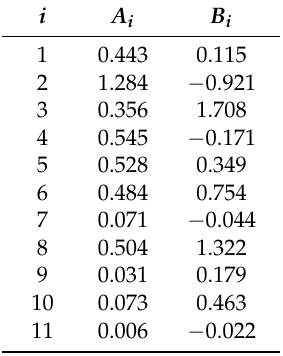
Table 2. The values of the general constants.